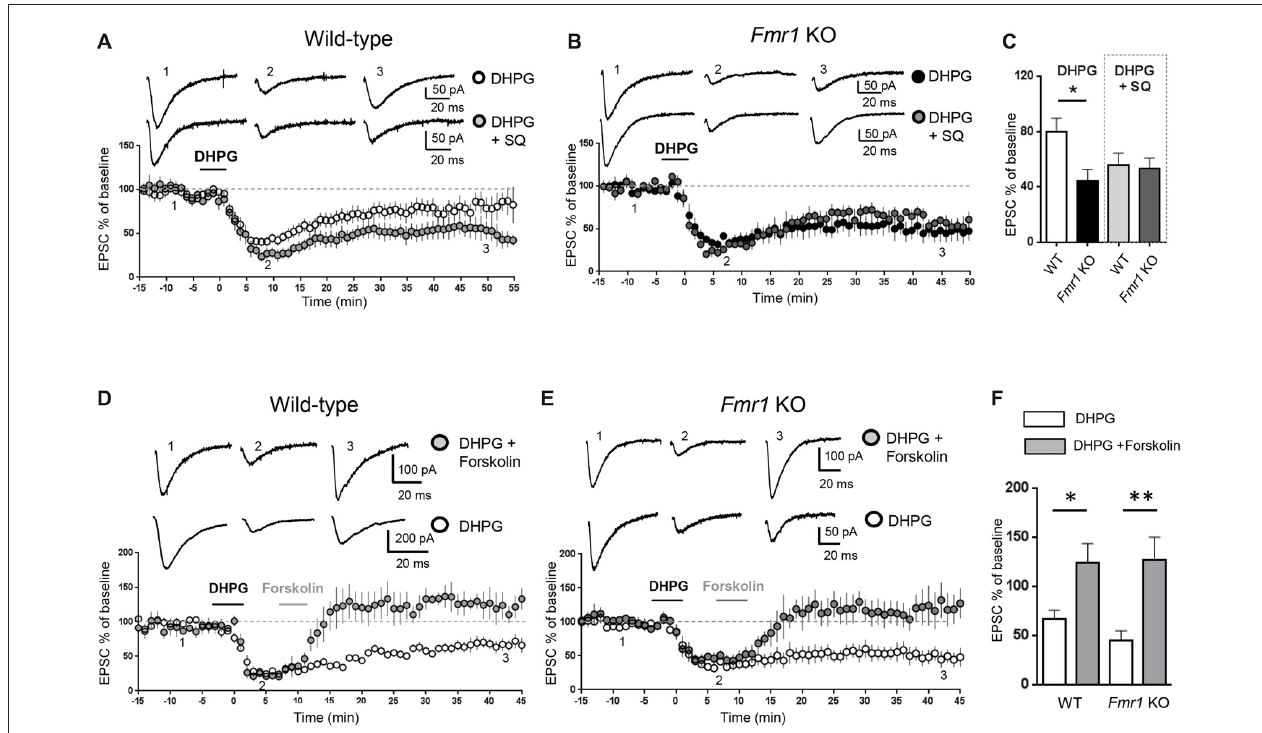
FIGURE 1 | Modulation of adenylate cyclase activity modified metabotropic glutamate receptor-mediated long term depression (mGluR-LTD) in wild-type (WT) and Fmr1 Knockout (KO) slices. AMPAR-mediated excitatory post-synaptic currents (EPSCs) were recorded in the presence of D-AP5 (50 µ M) and bicuculline (5 µ M) under whole-cell patch clamp in the CA3–CA1 synapse in hippocampal slices from WT and Fmr1 KO mice. (A) In WT slices, bath application of the group I mGluR agonist (S)-3,5-dihydroxyphenylglycine (DHPG; 100 µ M, 5 min) induced a long-term depression (mGluR-LTD) of EPSC amplitude (white dots, n = 11). When the adenylate cyclase blocker SQ 22536 (SQ, 10 µ M) was added to intracellular medium, DHPG-induced mGluR-LTD was slightly enhanced (gray dots, n = 8) with respect to control. Individual representative EPSC traces are shown on top of the graph (1: baseline; 2: acute EPSC reduction; 3: mGluR-LTD). (B) In Fmr1 KO